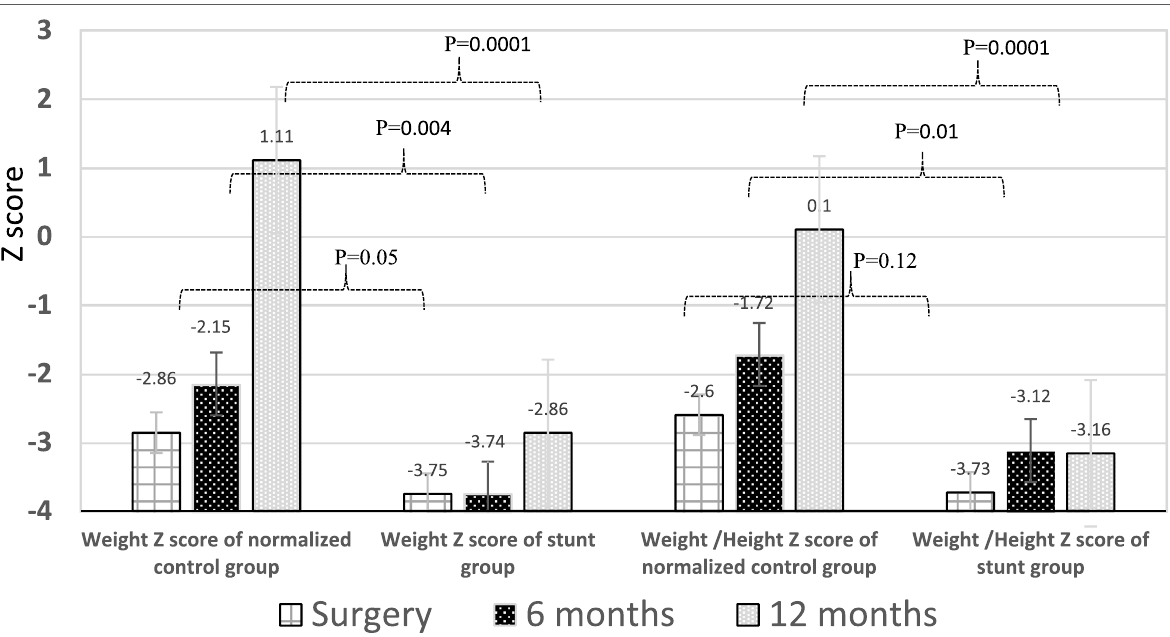
Fig. 3 Weight and weight/height Z score for normalized control group and underweight group at surgery, 6 months and 12 months